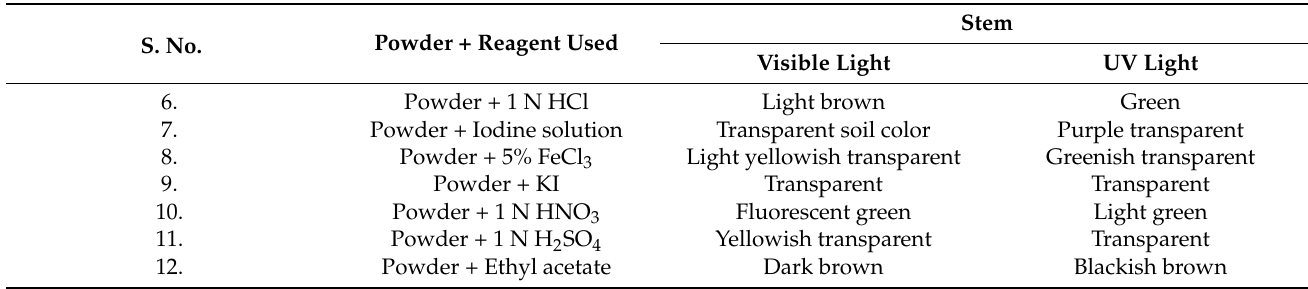
Table 5. Fluorescent behavior of N. triquetra leaf powder upon treatment with different chemical reagents. S.